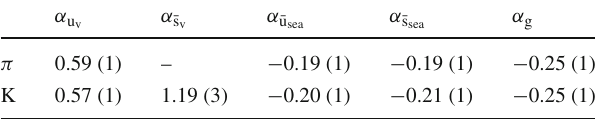
Table 3 Assuming PDFs obey ∝ x α in the small- x region approaching 0,welisttheobtainedvaluesofthepower α forvalencequark,seaquark and gluon distributions of the pion and the kaon at Q 2 = 20 GeV 2 . The α values are extracted from the fits in the range of 10 − 6 < x < 10 − 1 . The errors in the table indicate the 1 σ uncertainties